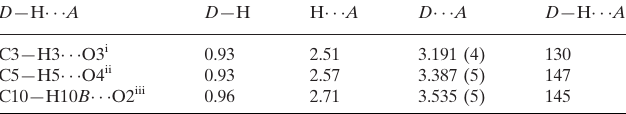
Hydrogen-bond geometry (A˚ , (cid:2)